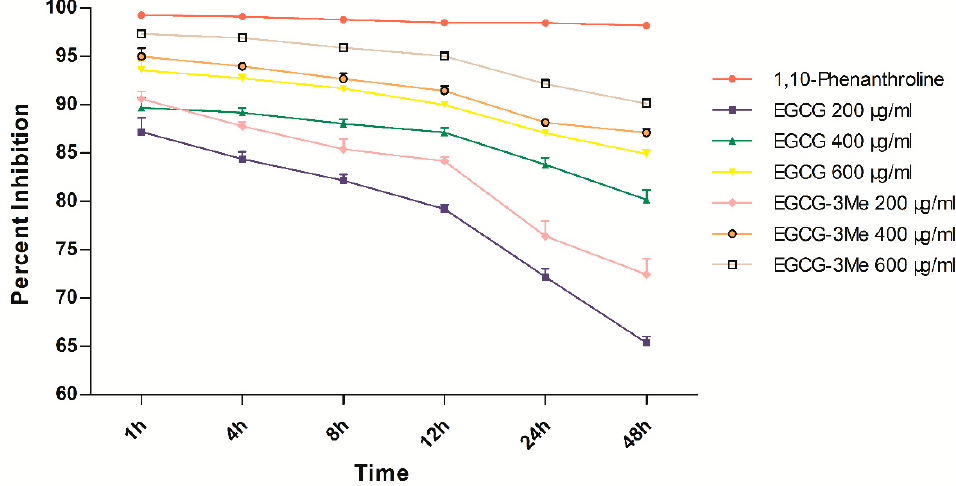
Figure 5. The percent inhibition of dentin-originated collagen proteases activities by increasing concentrations of EGCG and EGCG-3Me at each time points. EGCG, epigallocatechin-3-gallate; EGCG-3Me, epigallocatechin-3- O -(3- O -methyl)-gallate. Table 4. Degree of conversion values